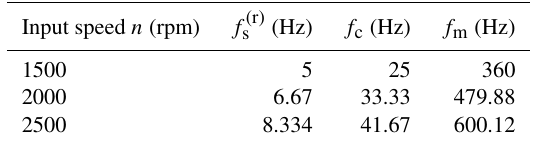
Table 3. Characteristic frequency of the planetary